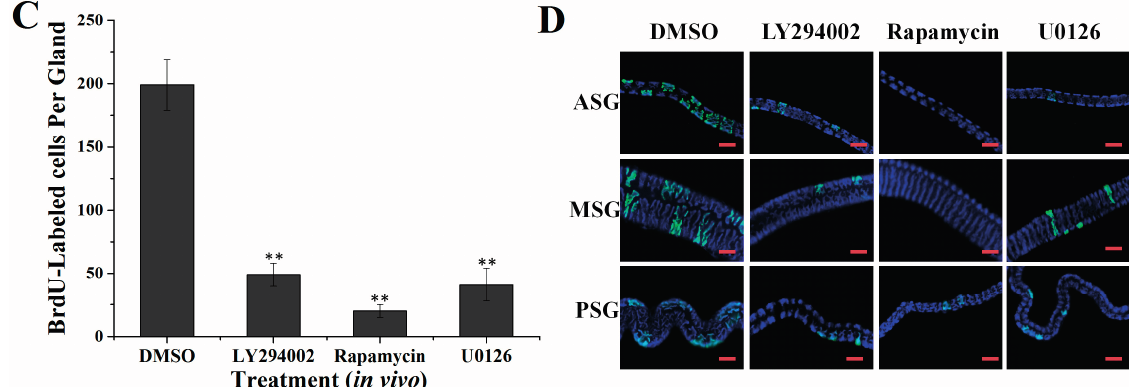
Figure 2. Effects of the specific pathway inhibitors on DNA synthesis in silk gland cells. ( A ) Concentration dependent effects in vitro ; ( B ) Time-dependent effects in vitro ; ( C ) Effects of inhibitors in vivo ; ( D ) Representative images of BrdU-labeled silk gland cells 24 h after injection with each specific inhibitor. Scale bar = 100 µm. ASG: anterior silk gland; MSG: middle silk gland; PSG: posterior silk gland. * p < 0.05, ** p < 0.01. 2.3. Involvement of the PI3K/Akt and TOR Signaling Pathway in Insulin-Stimulated Endomitotic DNA